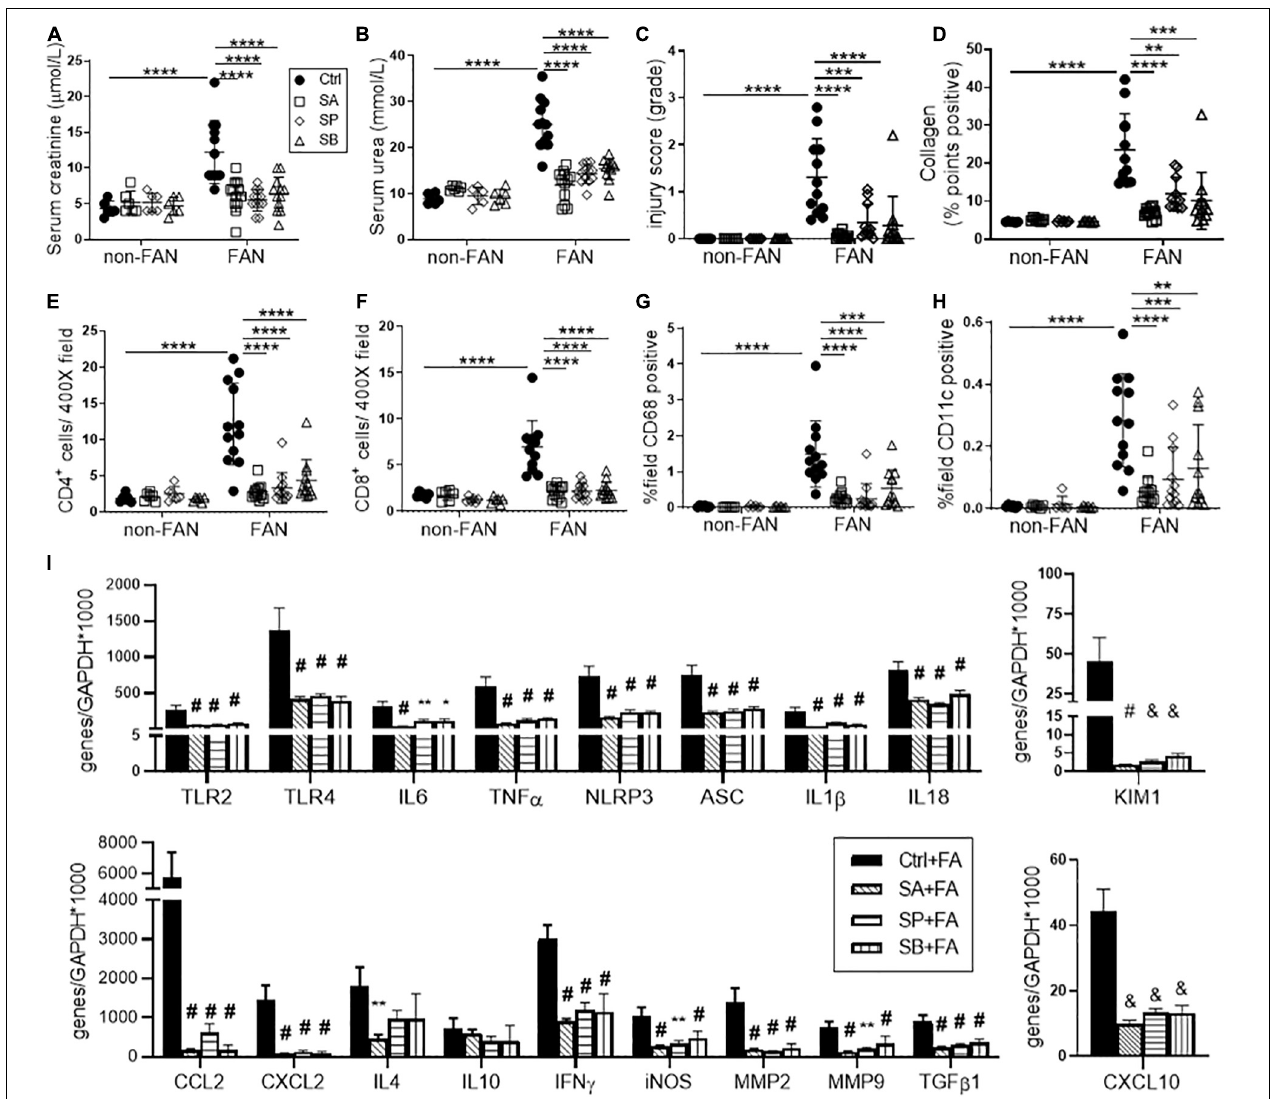
FIGURE 6 | SCFA supplementation resulted in less chronic inflammation at day 28 after FAN induced AKI. SCFA treated mice developed less severe chronic kidney injury, as evidenced by lower serum creatinine (A) , BUN (B) , histological injury scores (C) on PAS staining, and diminished collagen deposition (D) on PSR staining at day 28. Reduced CD4 + , CD8 + T cell (E,F) , CD68 + macrophage (G) and CD11 + dendritic cell (H) infiltration was seen in SCFA treated FAN kidneys, quantified by immunostaining. (I) SCFAs diminished mRNA expression of innate immune receptors (TLR2 and TLR4), pro-inflammatory cytokines (IL6, TNF α , and IFN γ ), chemokines (CCL2, CXCL2, and CXCL10), inflammasome components (NLRP3, ASC, IL18, and IL1 β ), inflammatory mediator (iNOS), proximal tubule injury (KIM1), and fibrosis related genes (TGF β 1, MMP2, and MMP9) measured by real-time PCR in kidney tissue at day 28. FAN ( n = 12); non-FAN ( n = 6). Data are shown as means ± SD or mean ± SEM; * P < 0.05, ** P < 0.01, *** & P < 0.001, **** # P <